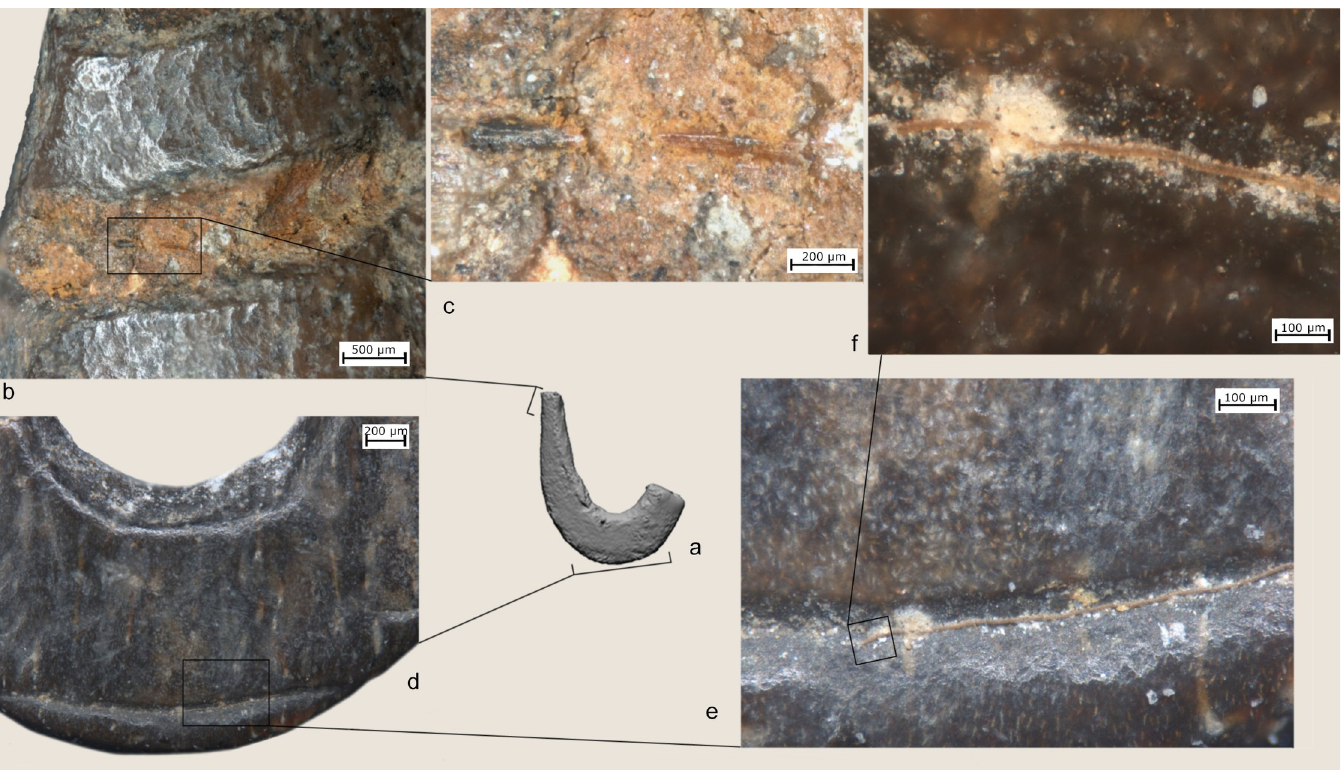
Fig 10. Technological traces, use wear traces and residues on archaeological hook # 9 a,b,c) details of a plant fiber identified inside the notch on the top of the shank; d-f) animal hair recovered inside the groove on the bend of the